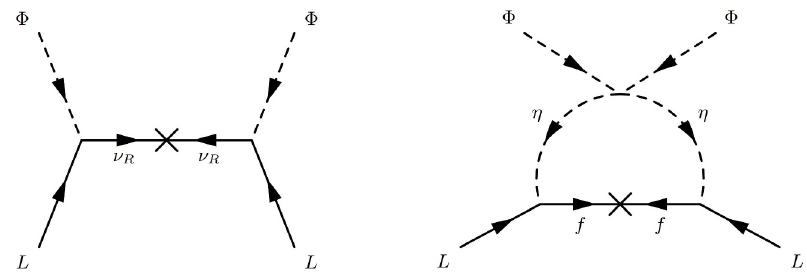
Figure 1 . Neutrino mass generation in the minimal “scoto-seesaw” model. The left (right) diagram corresponds to the tree-level seesaw (one-loop scotogenic) contribution to the effective dimension-5 neutrino mass operator LL ΦΦ